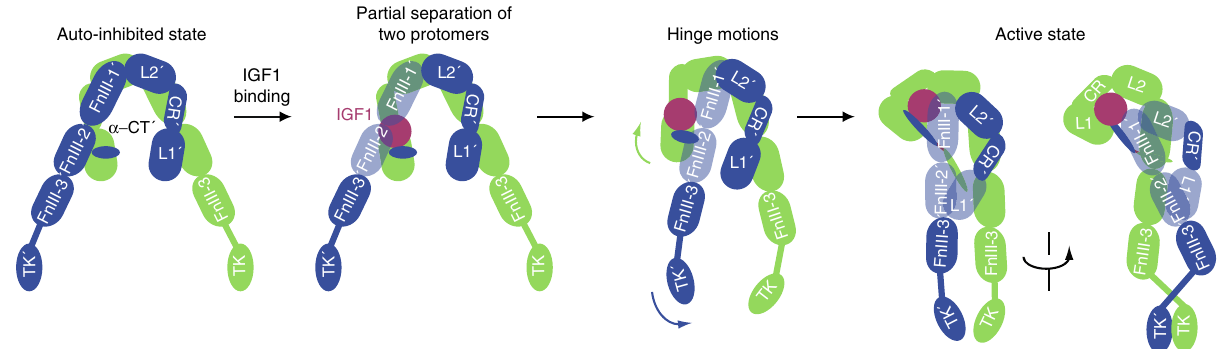
Fig. 6 Cartoon representation of a working model for IGF1-induced IGF1R activation. The two IGF1R protomers are colored in green and blue, respectively; the IGF1 is colored in pink. The name of each domain is labeled as follows: L1 and L2 (leucine-rich repeat domains); CR (cysteine-rich domain); FnIII-1, FnIII- 2, and FnIII-3 ( fi bronectin type III domains); α -CT (the C-terminus of the α -subunit); TK (tyrosine